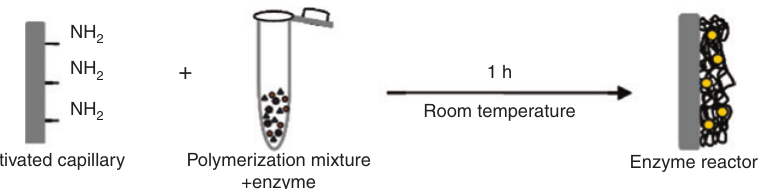
Figure 5: Schematic representation of the monolithic IMER. Enzymes were pre-mixed with polymer, then the enzyme-containing mixture was injected into activated capillary to produce monolithic